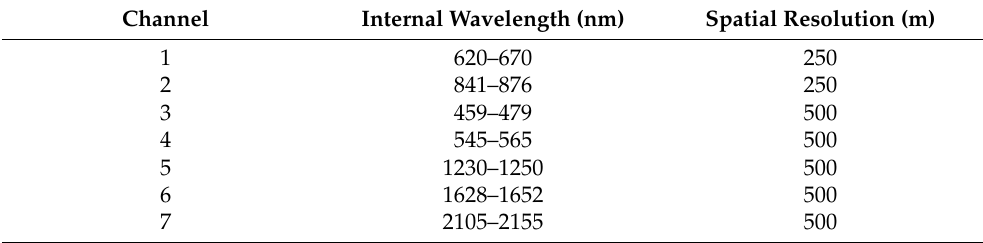
Table 1. Spatial resolution and internal wavelength of each channel in MOD02-1 km.